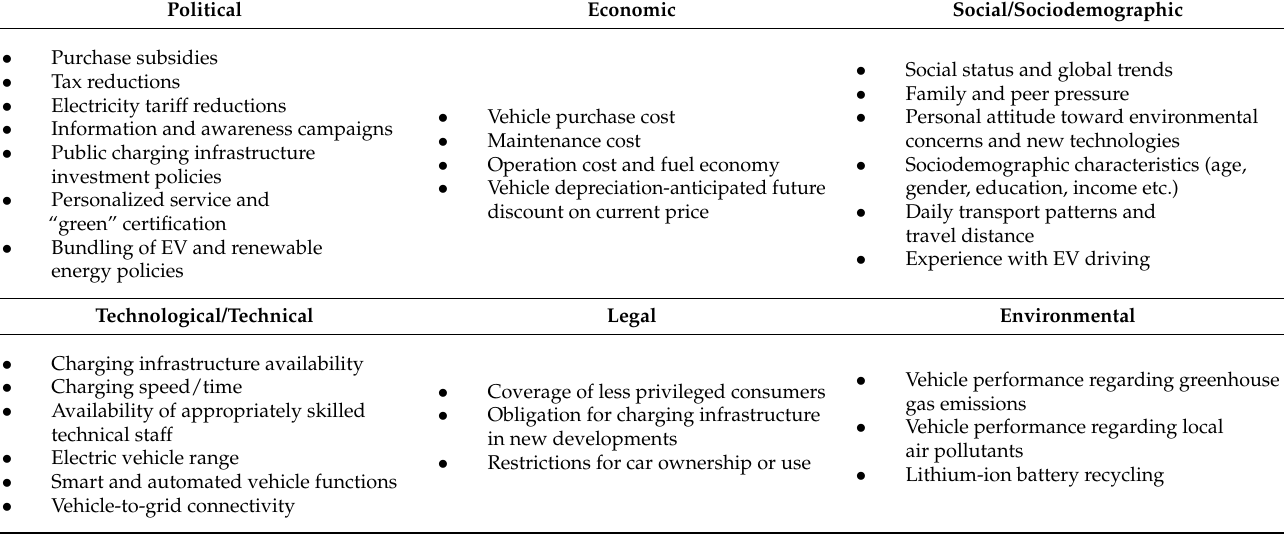
Table 2. Main determinants affecting EV consumer